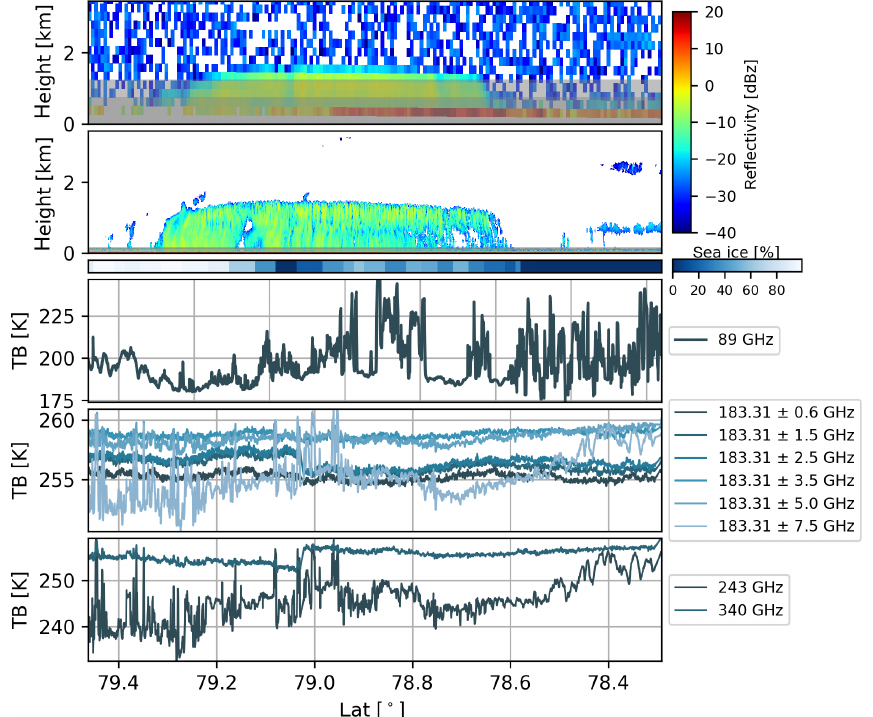
Figure 7. Vertical cross section of Z e measured by CloudSat CPR (top) and the MiRAC radar on Polar 5 (second row) for the satellite underflight on 27 May 2017 between 10:06 and 10:44UTC along the black dashed line in Fig. 4. Grey shaded areas define the zone of reduced sensitivity. The third row gives the sea ice coverage based on AMSR2 observations along the flight track. Rows four to six show the passive radiometer measurements at 89GHz from MiRAC-A and those channels of MiRAC-P, i.e., the six channels along the 183.31GHz water vapor absorption line, and the two channels at 243 and